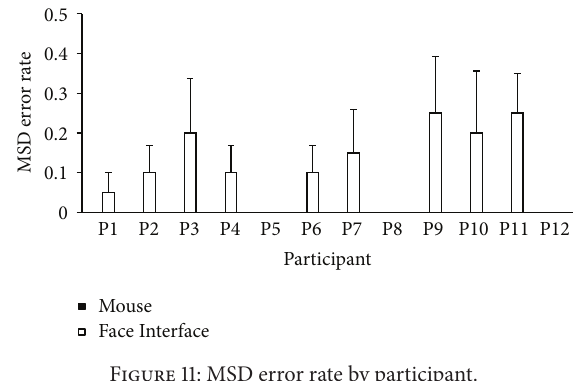
Figure 11: MSD error rate by participant. Table 1: Mean ranks of ratings of both techniques.